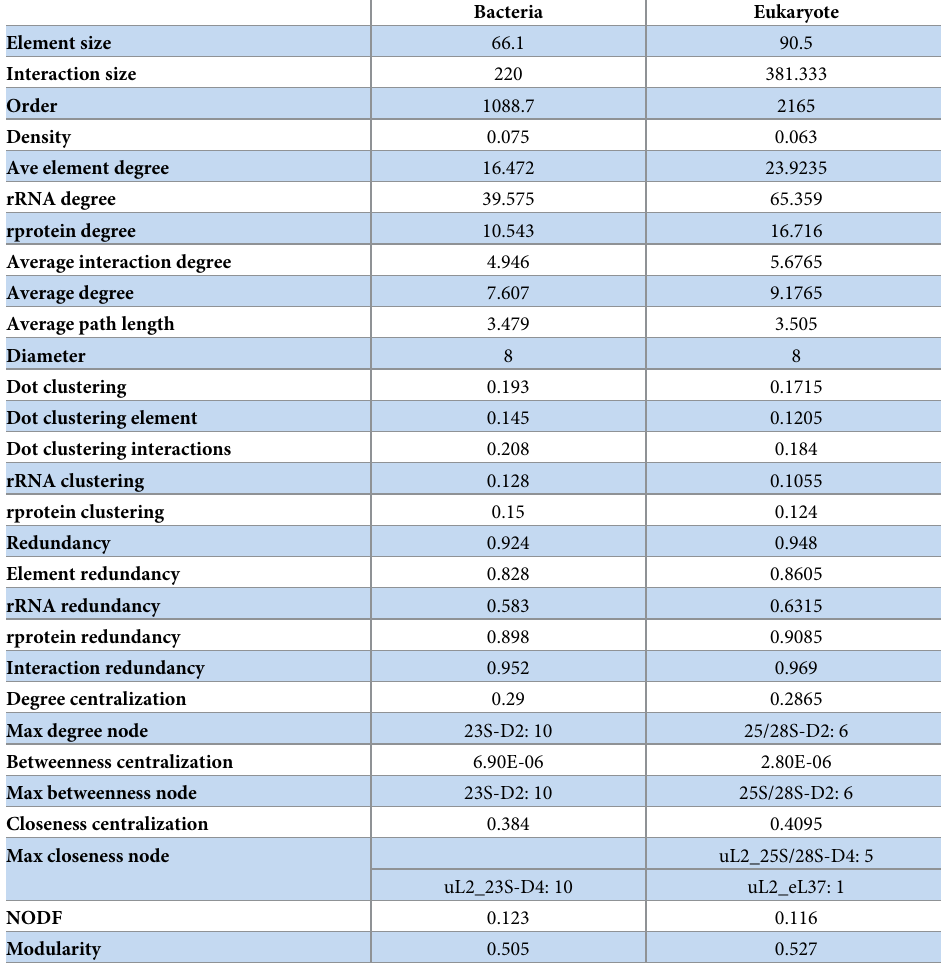
Table 1. Average basic properties of the bipartite